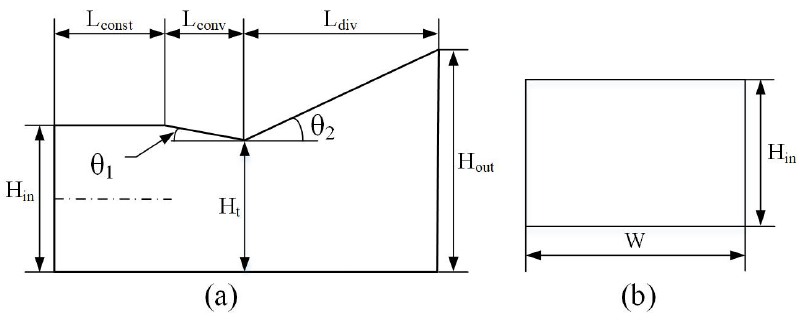
Figure 2. Sketch of the SERN. ( a ) Configuration of the SERN; ( b ) Injection